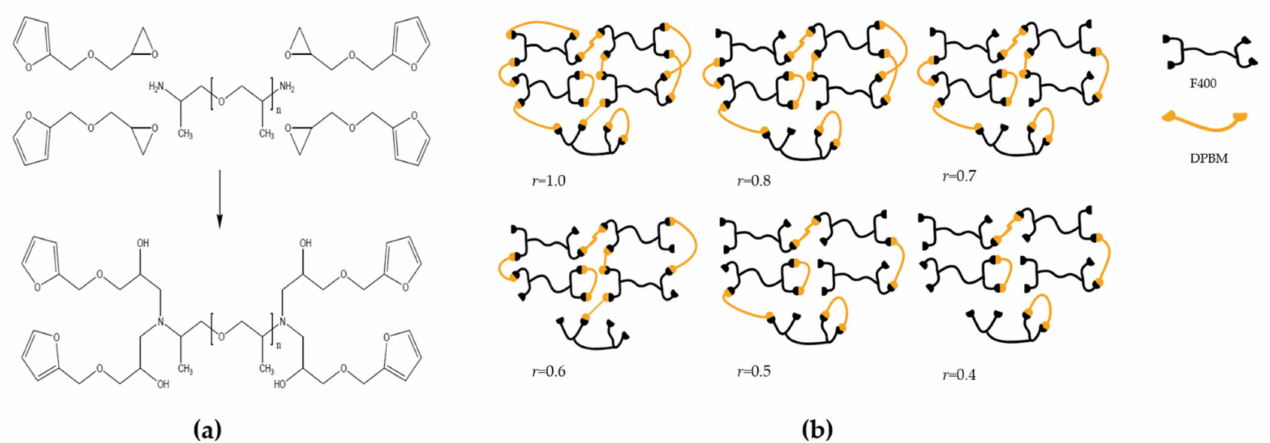
Figure 1. Two steps of synthesizing reversible polymer networks: ( a ) preparation of a four-functional furan compound through an epoxy-amine reaction between a Jeffamine D series amine (D400) and furfuryl glycidyl ether (FGE); ( b ) schematic of the reaction products of the furan functionalized Jeffamine (F400) with bismaleimide (DPBM) at full maleimide conversion for different maleimide to furan ratios ( r